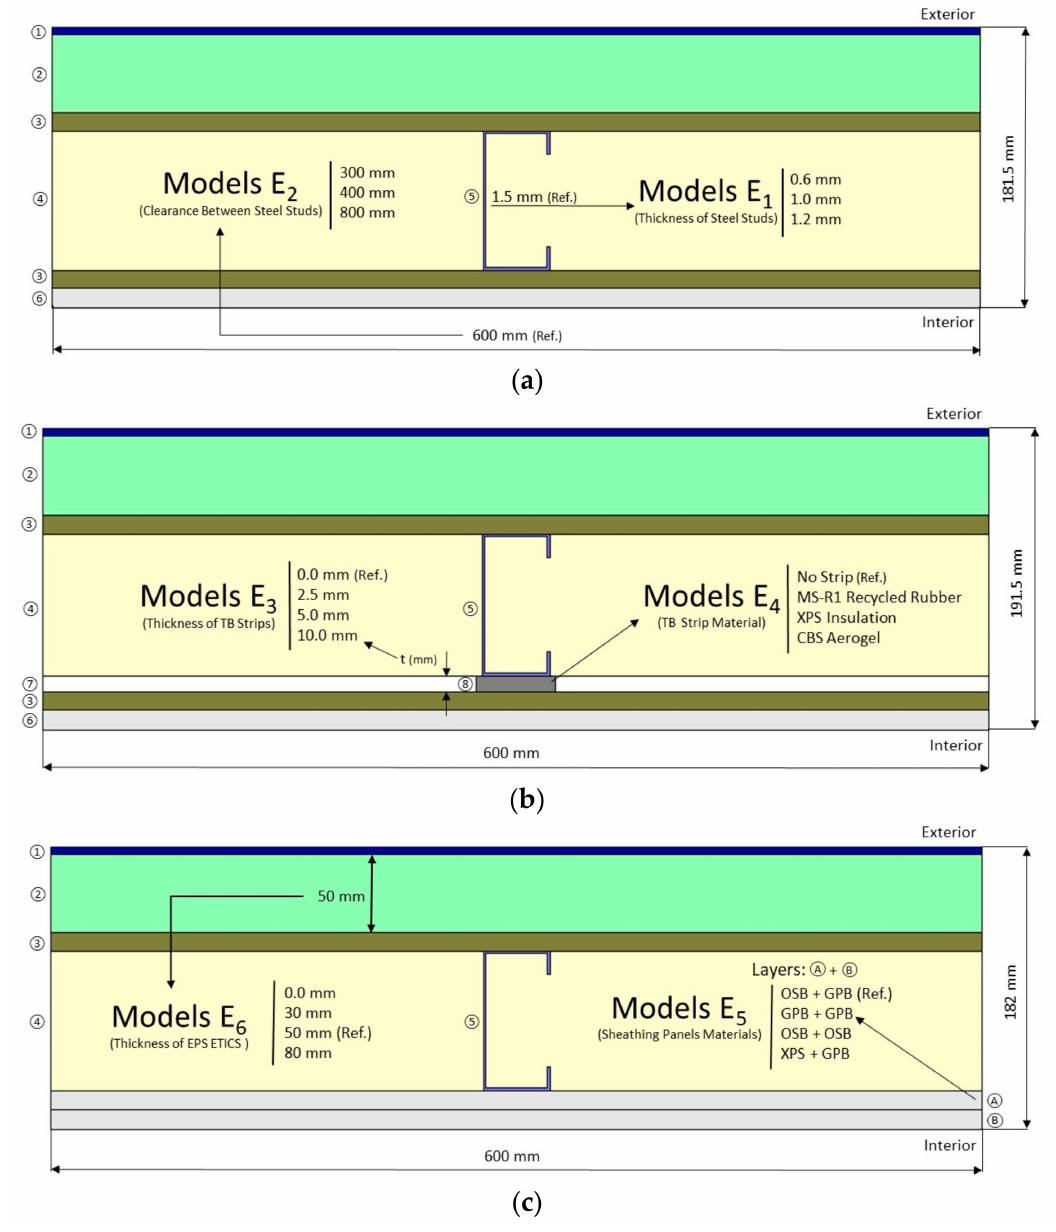
Figure 5. Exterior LSF facade cross-sections: ( a ) Models E1 and E2; ( b ) Models E3 and E4; ( c ) Models E5 and E6. Layers: 1 (cid:79) ETICS finish; 2 (cid:79) EPS; 3 (cid:79) OSB; 4 (cid:79) mineral wool; 5 (cid:79) steel stud C90; 6 (cid:79) gypsum plasterboard (GPB); 7 (cid:79) air layer; 8 (cid:79) TB